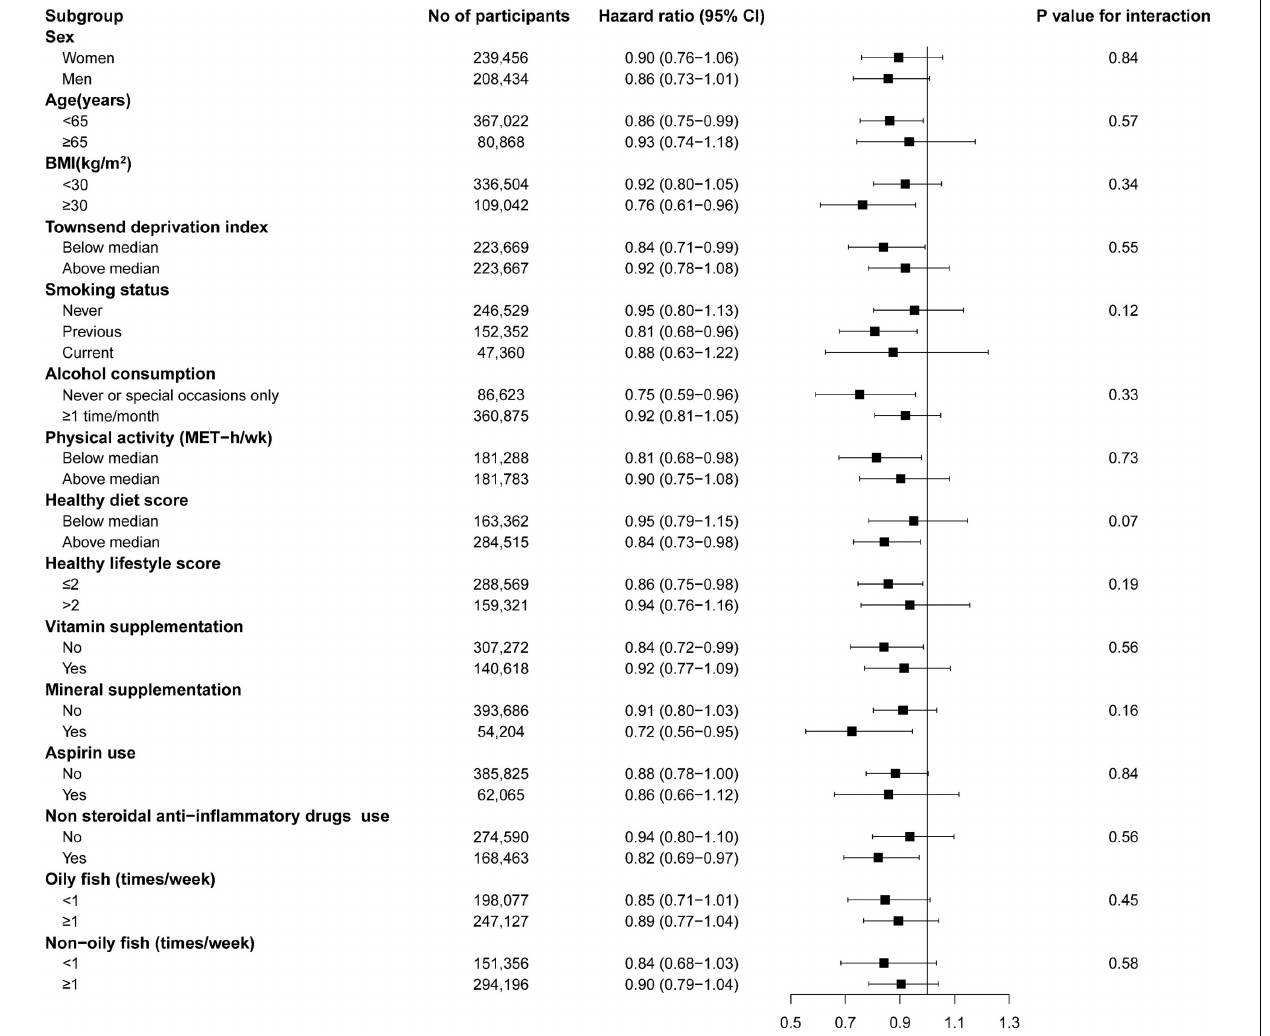
FIGURE 2 | The association of fish oil supplementation with inflammatory bowel disease risk in subgroup analyses. BMI, body mass index; MET, metabolic equivalent of task. Forest plots show the multivariable HRs of IBDs associated with fish oil use in subgroups. Model was adjusted for age, sex, race,